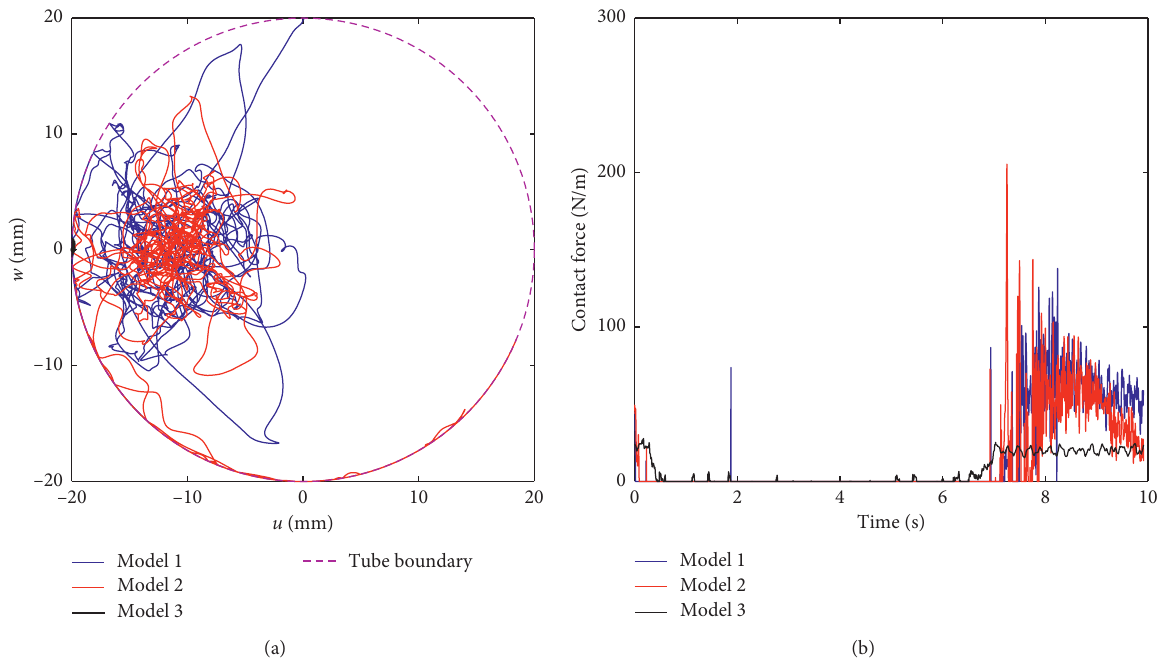
Figure 13: Simulation results of the rod node at 1283m. (a) Node position. (b) Contact force between the rod and Table 4: Statistical table of rod-tube contact force characteristic values of specific nodes in one cycle.